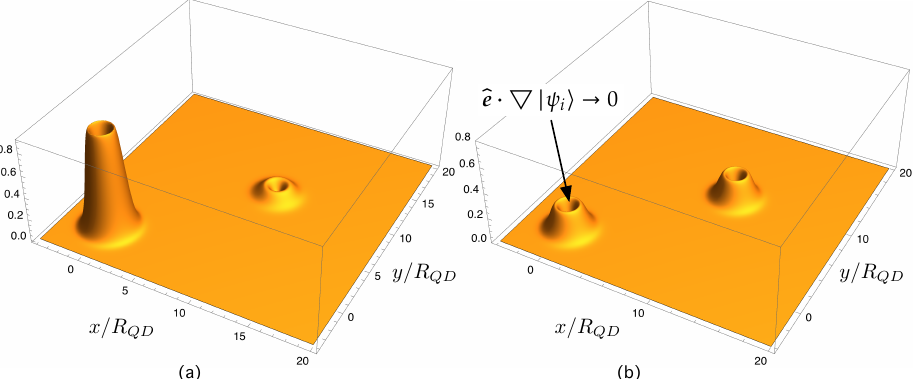
Figure 7. Gradient of electron wave function, (cid:98) e approaching the dot center.